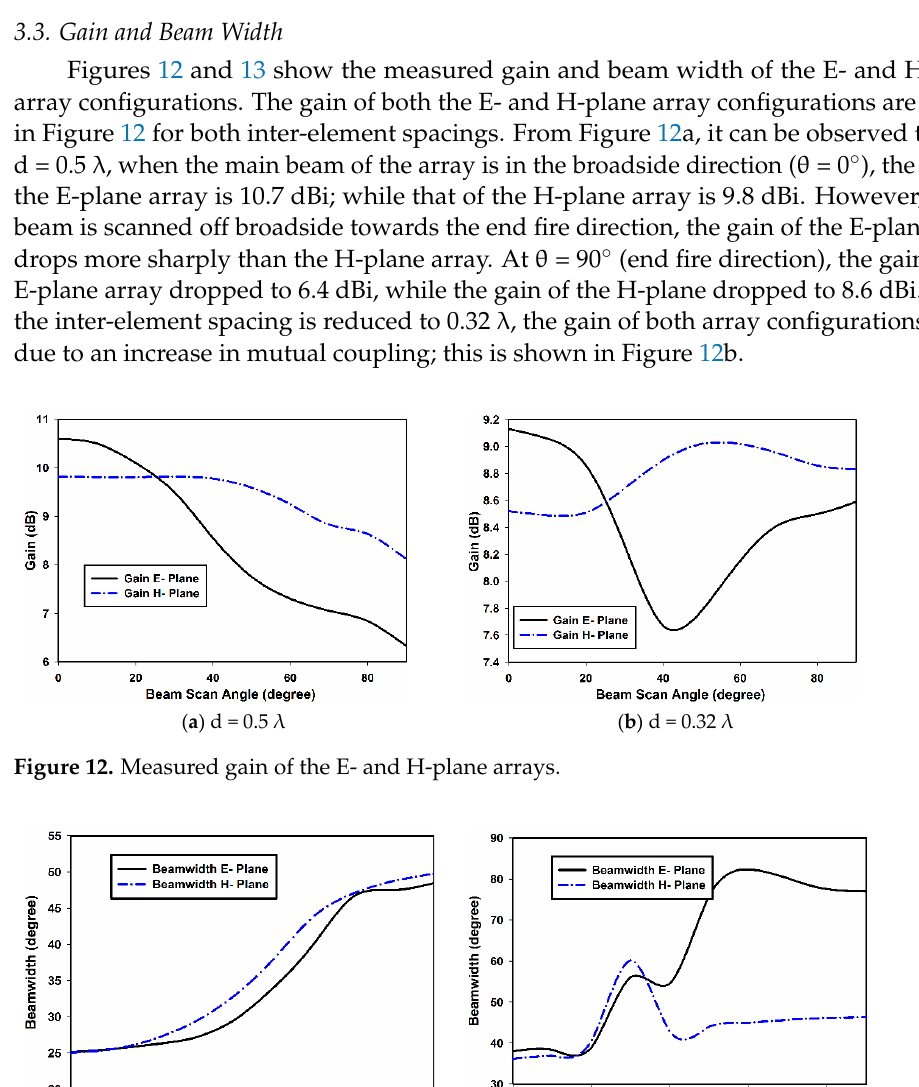
Figure 13. Measured beam width of the E- and H-plane arrays. For the E-plane array, the gain at θ = 0° is almost 9.2 dBi, which drops to 7.6 dBi